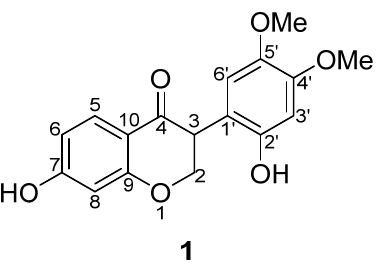
Figure 1. Chemical structure of 7,2 ′ -dihydroxy-4 ′ ,5 ′ -dimethoxyisoflavanone ( 1 ).